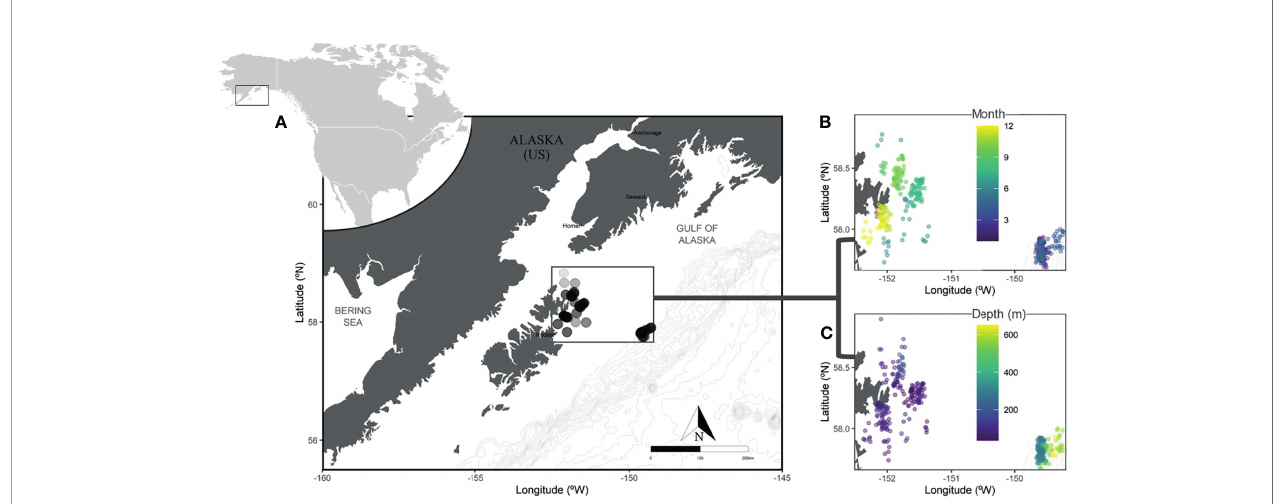
FIGURE 1 | Sampling locations in the Gulf of Alaska Portlock region with light gray bathymetry lines at 100-meter intervals. All sampling occurred within the dark gray box; each fi sh is represented by a transparent dot where darker, more opaque areas produced more samples (A) . The location and month (B) or depth in meters (C) of samples collected. Locations are jittered both horizontally and vertically to better display overlapping information, with depth and month displayed by color with blue representing both shallower depths or samples from the beginning of the year (e.g. January), and yellow representing greater depths or seasonally later